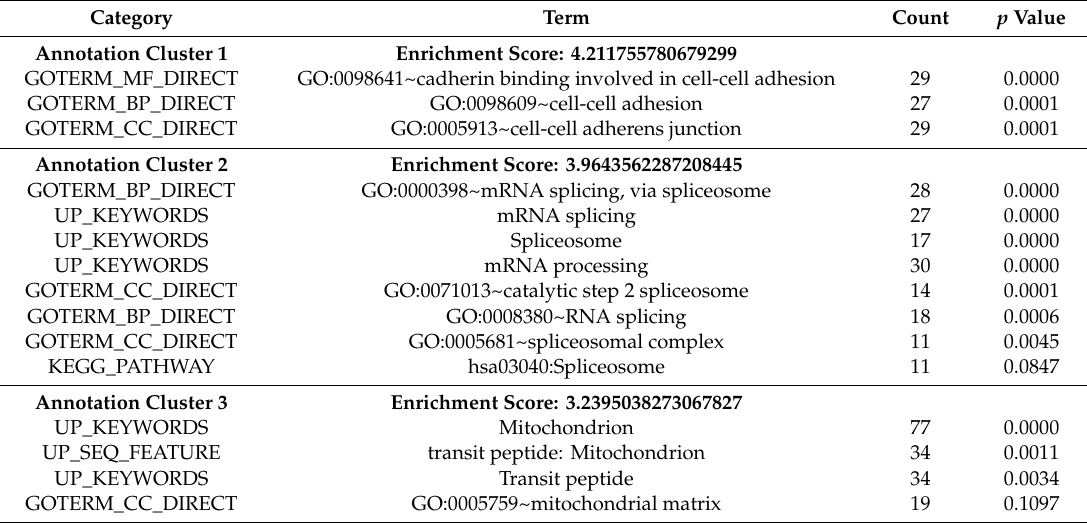
Table 3. Functional annotation of genes expressed uniquely in specimens from female patients with Cushing’s